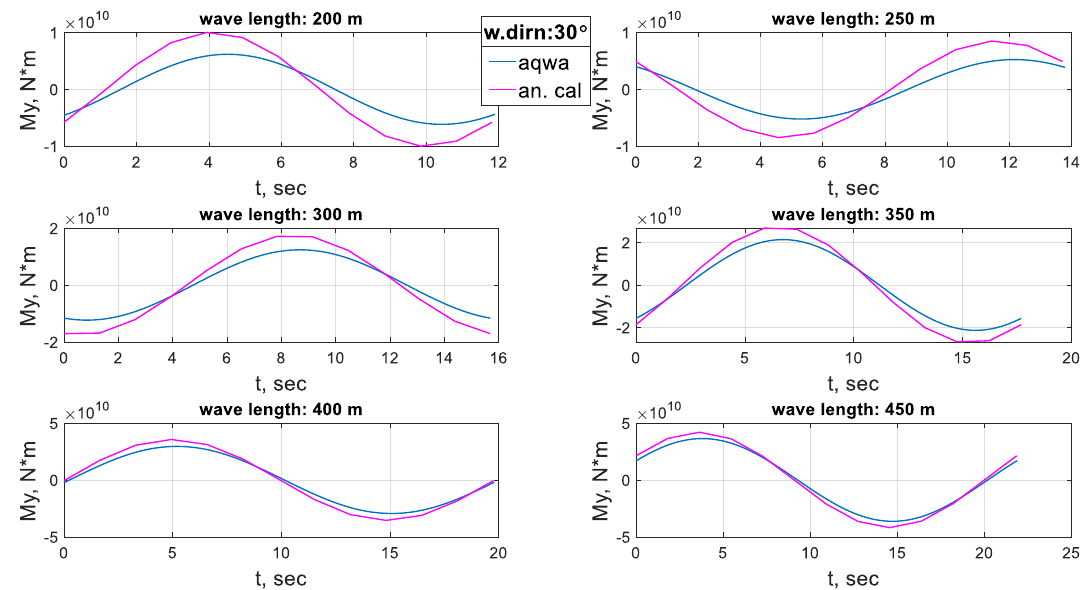
Figure 6. A comparison of vertical bending moments ( 𝑀 𝑦 ). The incident wave splitting forces calculation by AQWA is in blue, while the hydrostatic wave load by analytic calculation is in magenta. From top to bottom, left to right: bending moment plots for wavelengths of 200 m, 250 m, 300 m, 350 m, 400 m, 450 m.